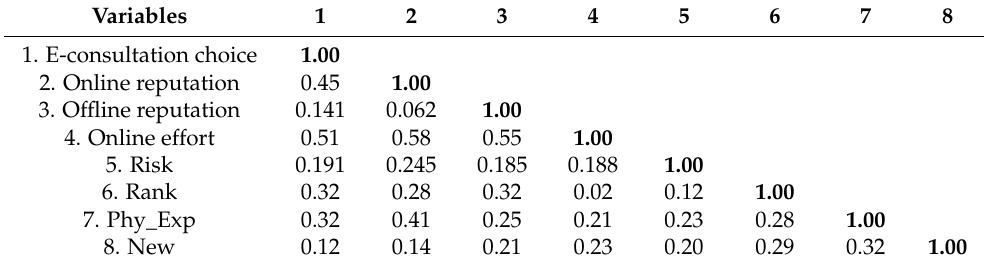
Table 2. Variables’